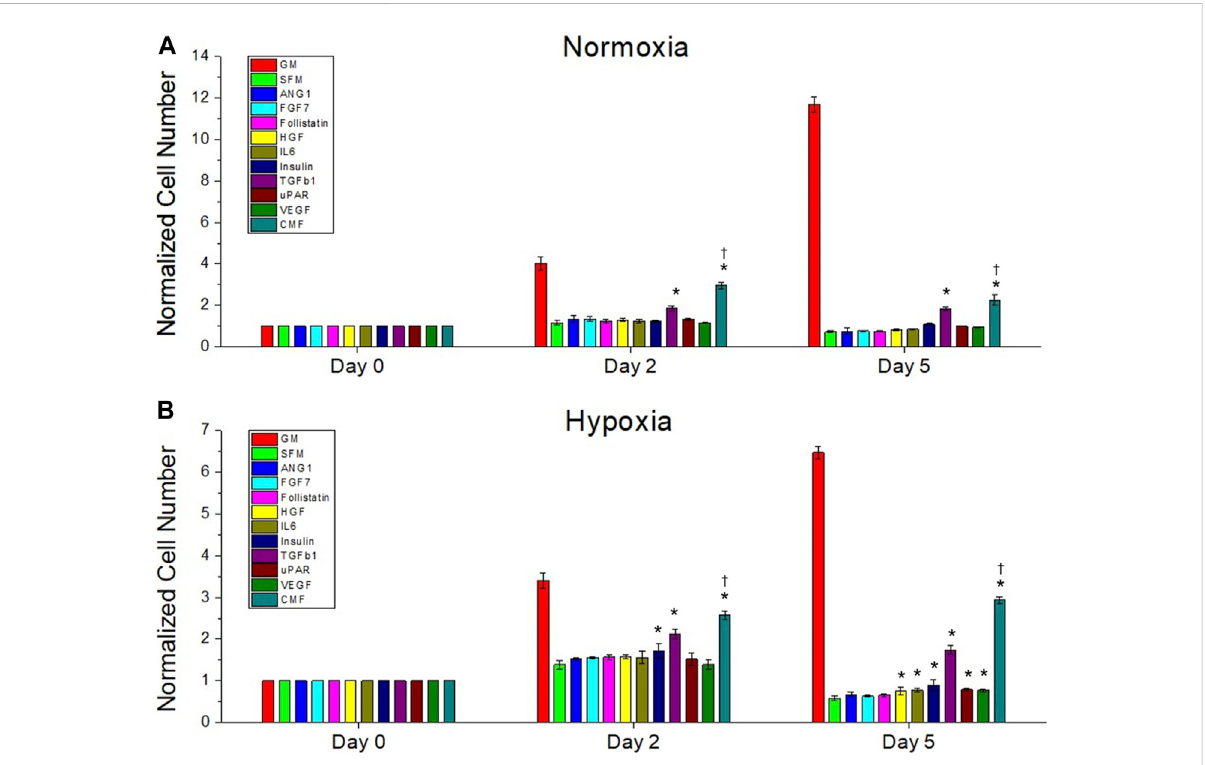
FIGURE 3 The effect of recombinant protein combination (CMF) on HDF growth compared with individual protein. Treatment with individual proteins (ANG-1, FGF-7,Follistatin, HGF,IL-6, Insulin,TGF β -1,uPAR,orVEGF)ortheircombination(CMF-ANG-1,FGF-7,Follistatin, HGF,IL-6, Insulin,TGF β - 1, uPAR, and VEGF) for 0, 2, and 5 days culture under normoxic (A) and hypoxic (B) conditions. The cell number of each group is measured using AlamarBlue assay and normalized to the day 0 cell number. The CMF shows signi fi cantly increased cell number compared with all individual proteins ( † p < 0.05) at day 2 and day 5 in normoxia and hypoxia ( n = 3, duplicate measure, two-way ANOVA and Tukey ’ s test, * p < 0.05 with SFM, † p < 0.05 with ANG-1, FGF-7, Follistatin, HGF, IL-6, Insulin, TGF β -1, uPAR, and VEGF).